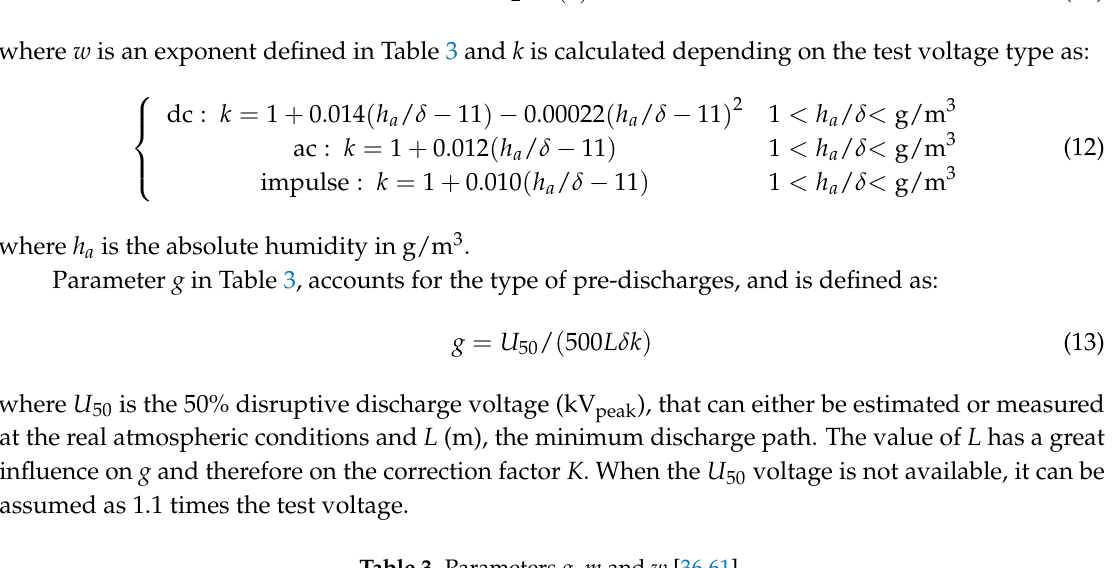
Table 3. Parameters g , m and w